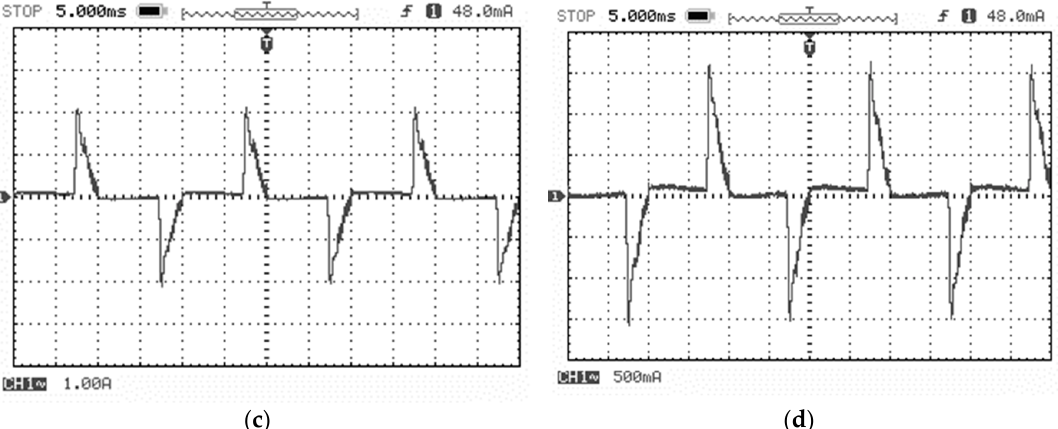
Figure 5. Experimental waveform for case of LED lamp and driver with brand A. ( a ) Current waveform in the case of one lamp with one driver; ( b ) Current waveform in the case of two lamps with two drivers; ( c ) Current waveform in the case of eight lamps with one driver; ( d ) Current waveform in the case of eight lamps with eight drivers.